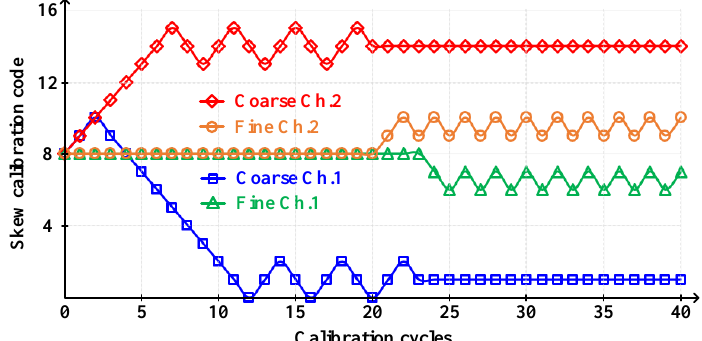
Figure 18. ( a ) The coarse-fine offset calibration convergence for window detecting comparator, and ( b ) its corresponding forced offset voltage.